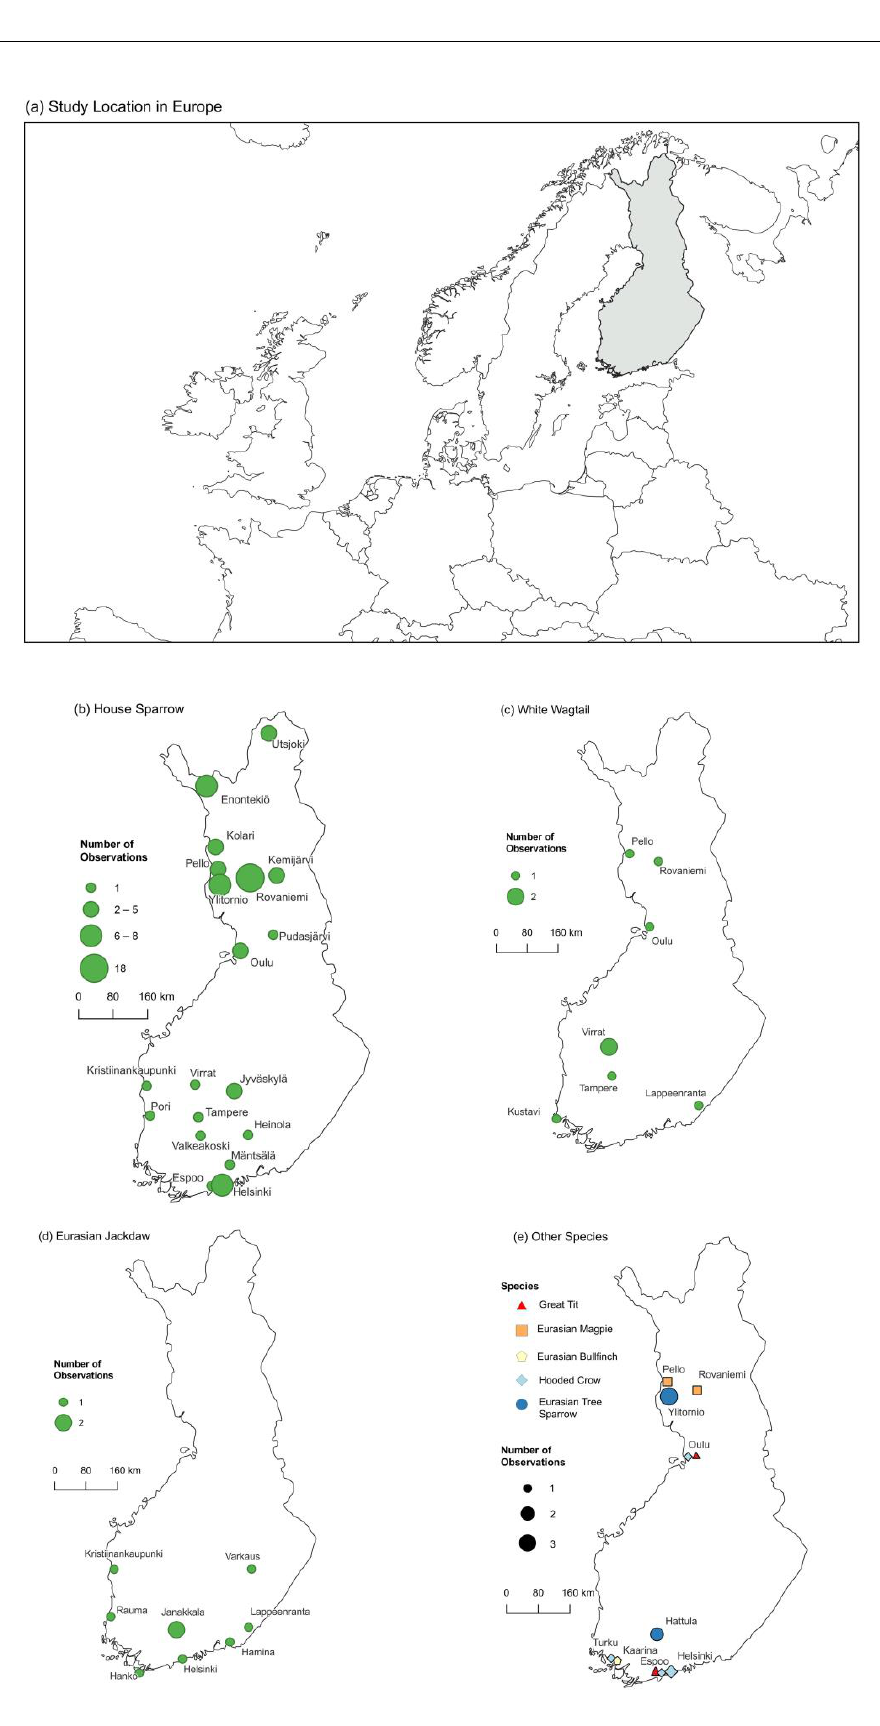
Figure 2. ( a ) Location of the study area; Number of observations of the ( b ) House Sparrow; ( c ) White Wagtail; ( d ) Eurasian Jackdaw; and ( e ) Other species (Great Tit; Eurasian Magpie; Hooded Crow;